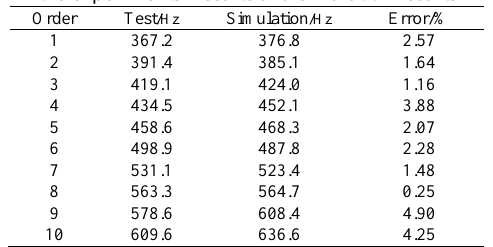
Table 2. Comparison of housing natural frequency between the experimental results and simulation results